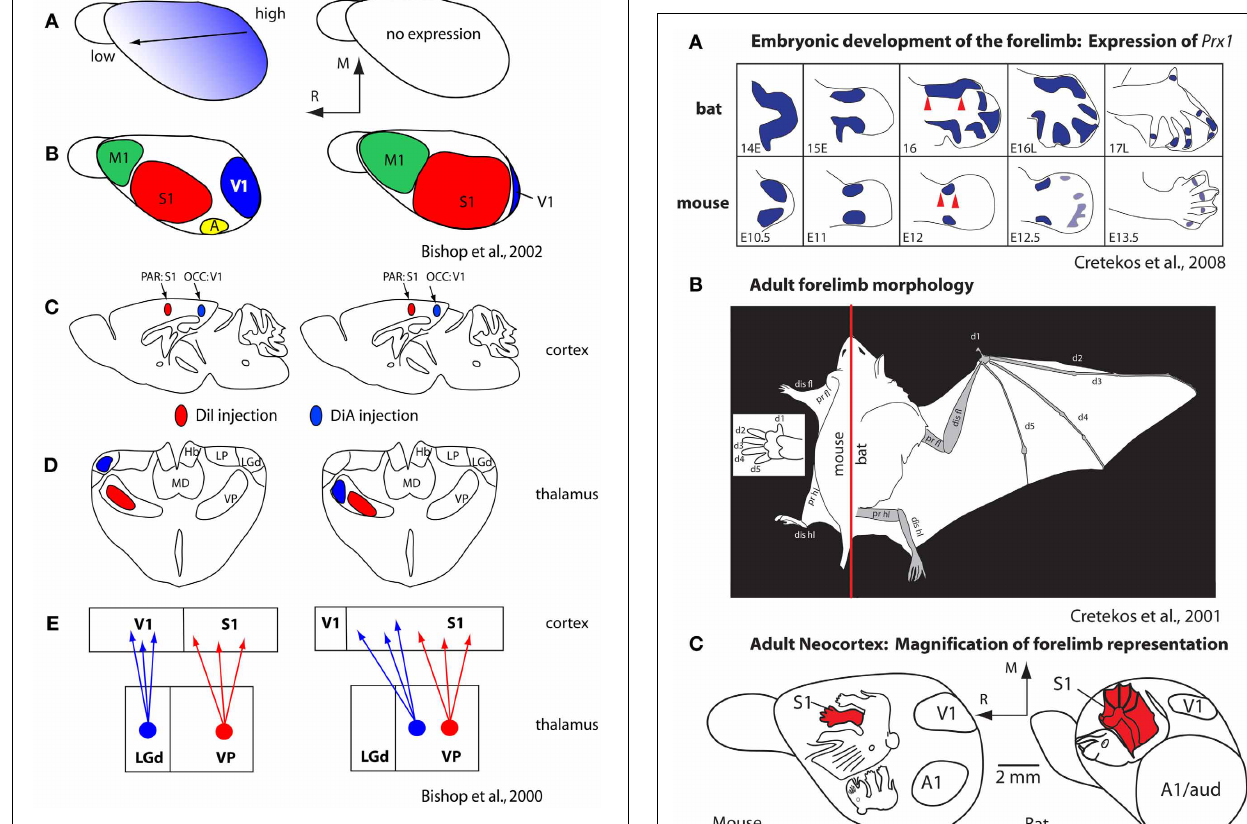
FIGURE 5 | (A) Graded expression of Emx2 in the normal (left) and mutant (right) mice. Normal expression generates normal patterns of cortical fields ( B ; left) and absence of Emx2 generates altered patterns of organization such that caudal domains have decreased (V1 is small) and rostral domains have expanded into the caudal territories ( B ; right). (C) Injections into parietal cortex (what will become S1) and occipital cortex (what will become V1) demonstrated altered patterns of thalamocortical connections (D) . In mutants what would normally develop into visual cortex has projections from VP, normally associated with somatosensory processing. The schematic in (E) demonstrates normal thalamocortical connections of S1 and V1 (left) and the caudal shift of VP projections into what would normally be visual cortex ( E ; right). These figures are modified from Bishop et al. (2000, 2002). Conventions as in previous figures.